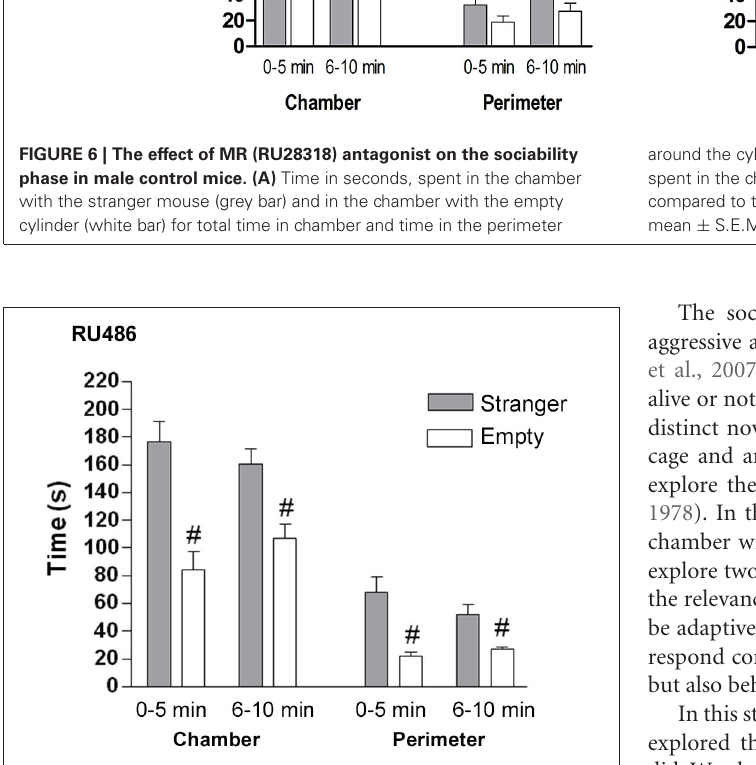
FIGURE 7 | The effect of GR (RU486) antagonist on the sociability phase in male control mice . Time in seconds, spent in the chamber with the stranger mouse (grey bar) and in the chamber with the empty cylinder (white bar) for total time in chamber and time in the perimeter around the cylinder. # p < 0.05 compared to the stranger chamber/perimeter. All data are expressed as mean ±